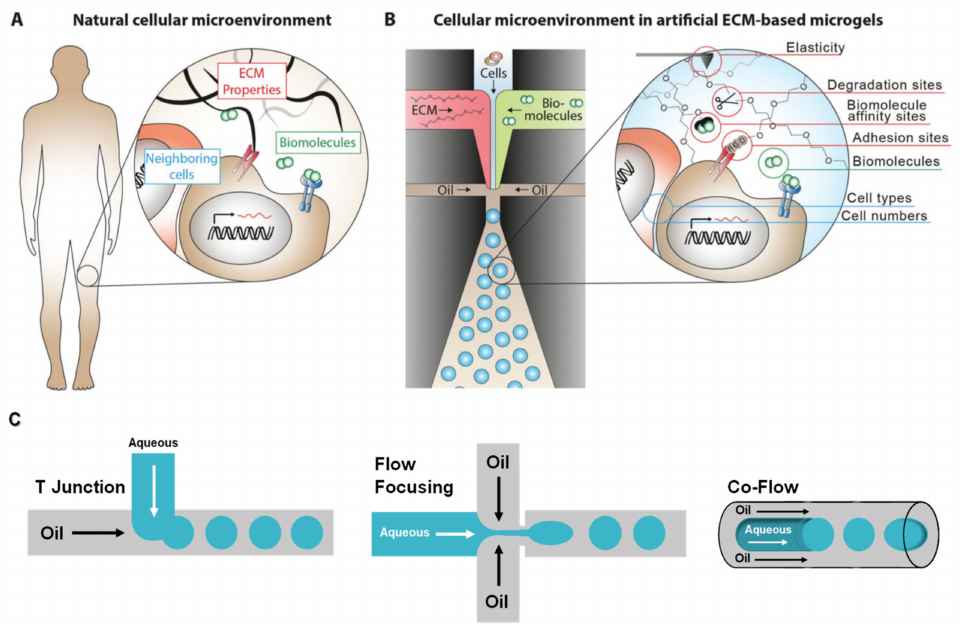
Figure 1. Recapitulating the natural cellular microenvironment in biomimetic microgels using droplet-based microfluidics. ( A ) The natural cellular microenvironment is composed of different cell types, ECM, and biomolecules such as growth factors. ( B ) Droplet-based microfluidics allows for versatile and high throughput generation of cell-laden microgels that can mimic the natural cellular environment. By mixing defined amounts of selected cells, ECM, and biomolecules, the microen- vironment can be designed in a bottom-up approach with defined properties [34]. ( C ) Schematic illustration of different types of droplet generators, including T-Junction, flow-focusing, and co-flow (capillary) configurations. Adapted with permission from John Wiley and Sons Copyright ®